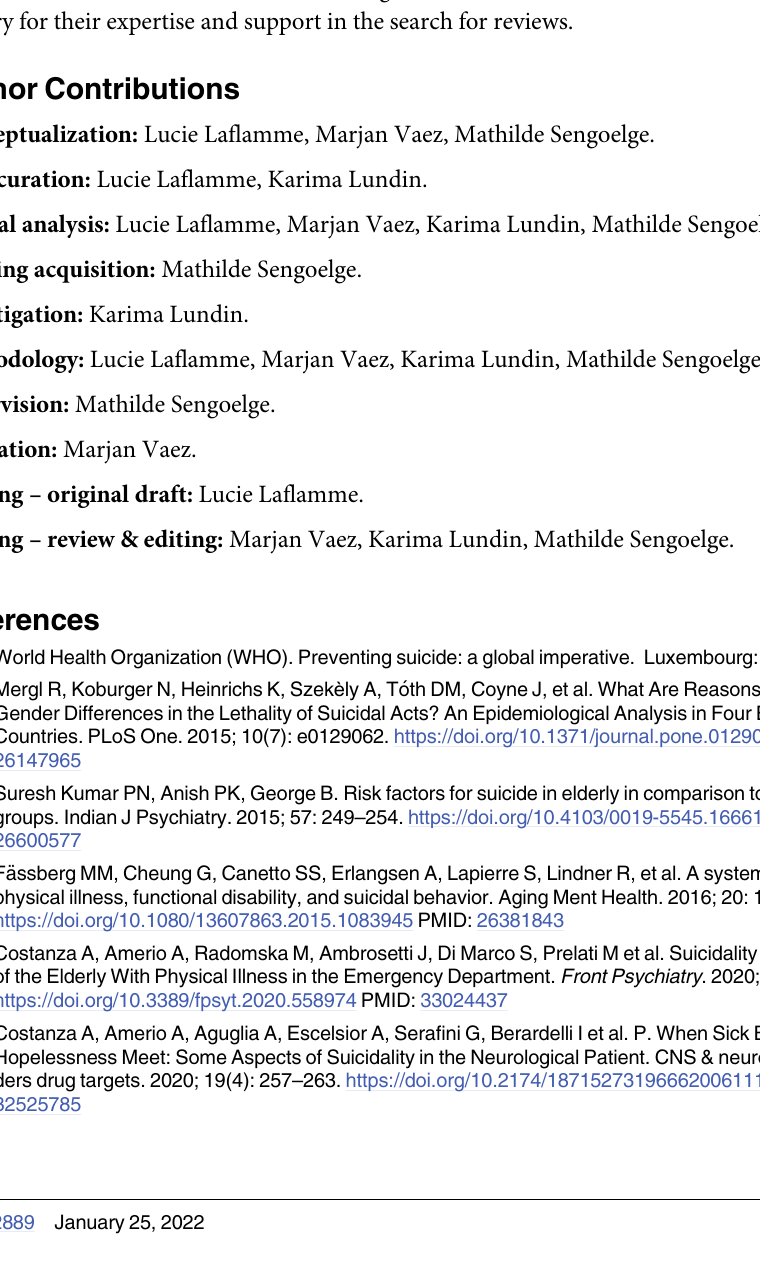
S1 Table. PRISMA checklist. S2 Table. Search strategy. S3 Table. SWiM reporting